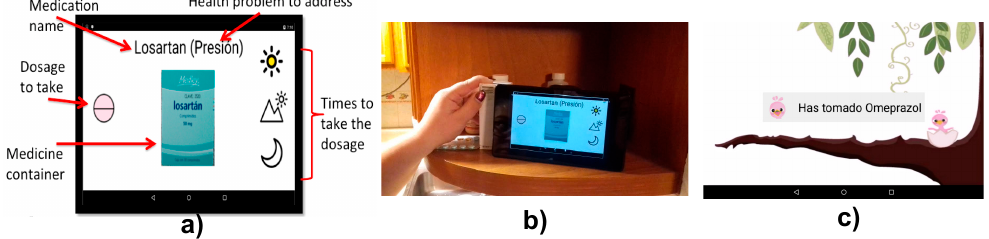
Figure 2. MAD reminding to medicate: ( a ) Pictogram-based reminder; ( b ) When each visual reminder is presented, senior should medicate and then move the corresponding medication container closer to the tablet in order for the NFC attached to it to be recognized by the tablet NFC reader; ( c ) MAD acknowledging that the medicine was registered as taken on